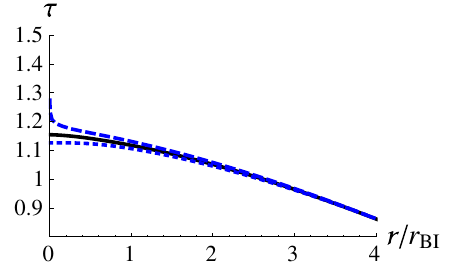
Fig. 3 The infalling proper time τ( r ) for ε = 1 is shown as a function of r / r BI . The dashed, dotted and the solid curves correspond to δ = 0 . 01, δ = − 0 . 01 and δ = 0 (GR) at x i = 10, respectively